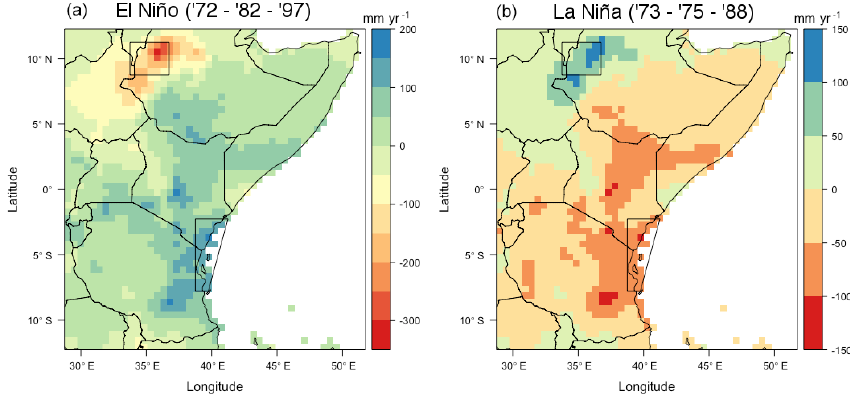
Figure 2. Regional maps of anomalies (mm yr − 1 ) for the strongest three (1972, 1982, 1997) El Niño (a) and (1973, 1975, 1988) La Niña (b) events in the 1951–2005 period (anomalies were calculated by subtracting precipitation without ENSO contribution from precipitation with ENSO contribution). Northern inner and southern coastal transects chosen for reporting results on vegetation